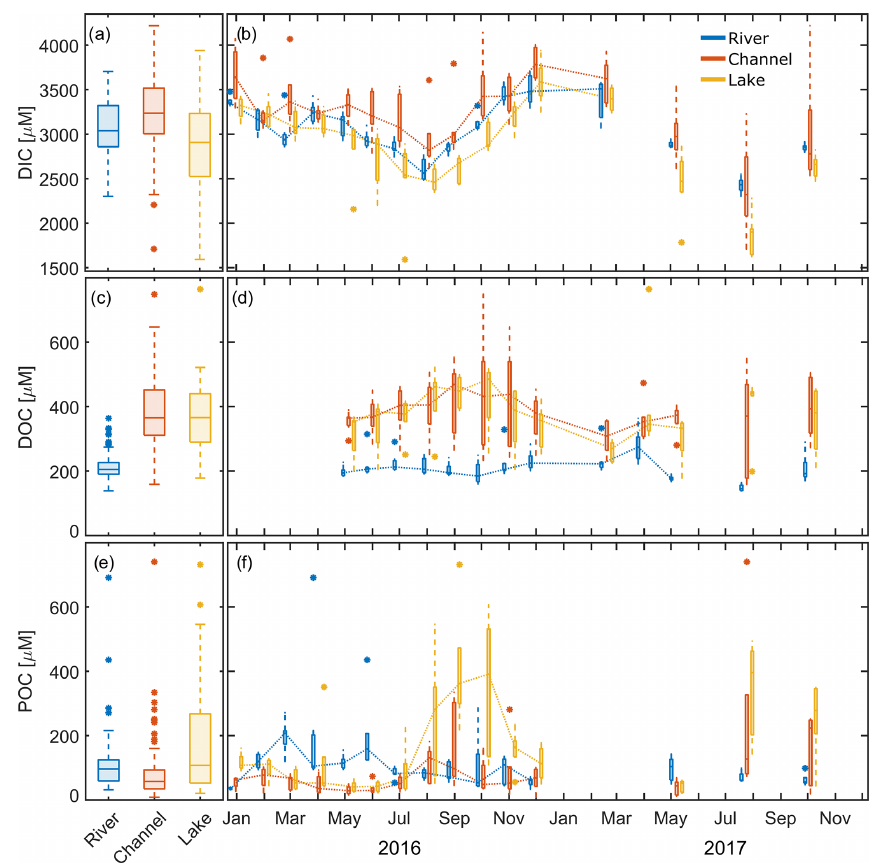
Figure 3. Measured DIC, DOC and POC concentrations in the different waterscapes (river, channel and lake). (a, c, e) The 2-year observation period. (b, d, f) Seasonality of the data. Dotted lines connect median values. The x axis ticks indicate the 15th day of the respective month. Box plots indicate 25 and 75 percentiles and median; whiskers indicate maximum and minimum, with data > 1.5 × IQR shown as